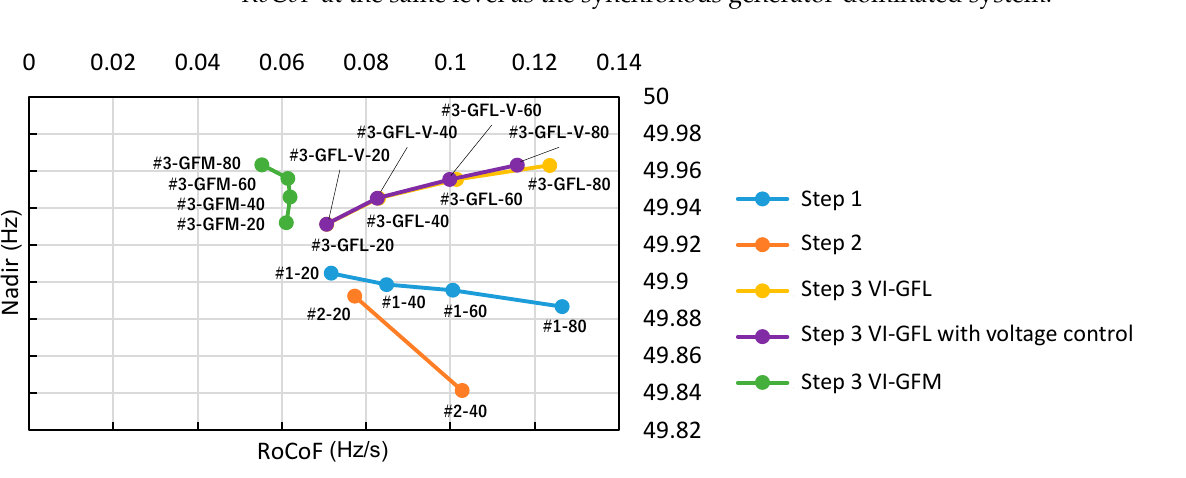
Figure 12. Indexed frequency stability for all cases.